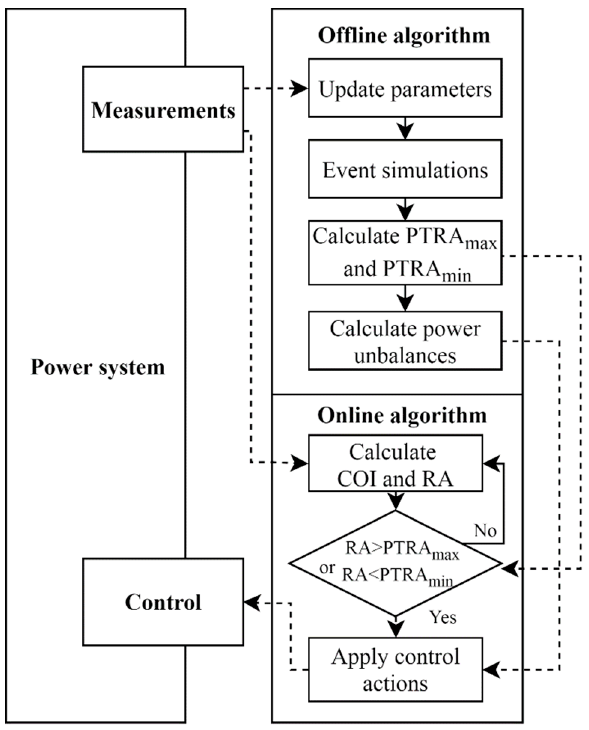
Figure 1. Flowchart of the algorithms to predict transient stability.